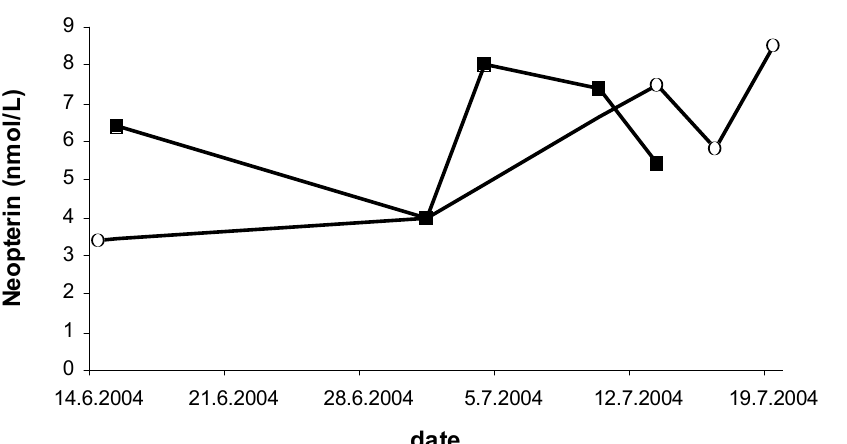
Figure 2. CSF and serum neopterin during intrathecal chemotherapy. Serum and cerebrospinal fluid neopterin in a patients with epithelial ovarian carcinoma carcinomatous meningitis. Shown are serum (open circles) and cere- brospinal fluid (filled squares) concentrations of neopterin during intrathecal chemotherapy. The patient (patient 1 in Table 1) with stage III EOC had brain metastasis diagnosed 31 months after primary surgery. The isolated brain metastasis was controlled with radiosurgery, surgery and chemotherapy. Forty-five months after the diag- nosis of brain metastases, the patient reported deterioration of neurological symptoms. Magnetic resonance imag- ing demonstrated regression of brain metastases. Because of the conflict between radiologic improvement and neurological deterioration, the diagnosis of meningeal carcinomatosis was suspected and spinal fluid was obtained for cytological analysis. Cytological examination confirmed presence of tumor cells. An Ommaya reser- voir was implanted for intrathecal therapy. By that time, left hemiparesis manifested and cognitive functions